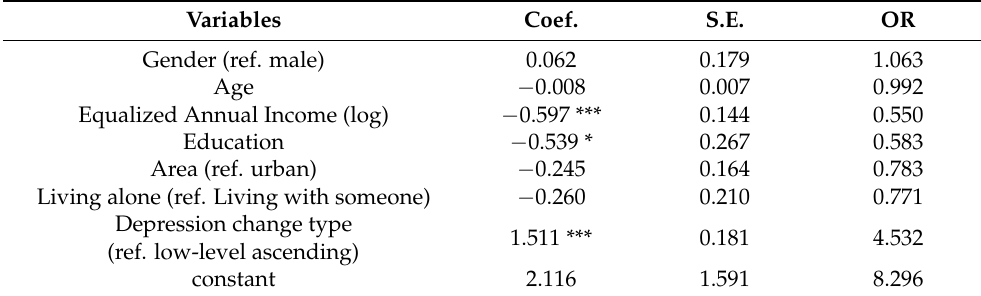
Table 5. The Relationship Between Depression Change Types and Suicidal Ideations. Variables Coef. S.E.